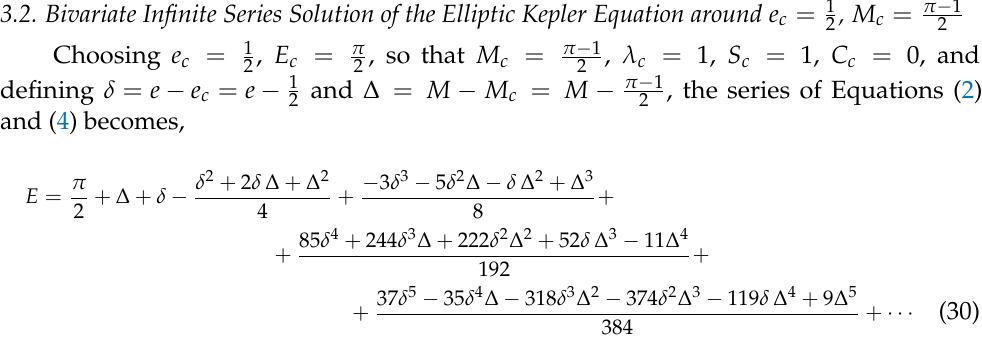
Figure 2. Contour levels of the error E 5 ( e , M ) affecting the fifth degree polynomial approximation, Equation (27), as a function of the eccentricity e and the mean anomaly M (both in logarithmic scales). The continuous magenta curve marks the boundary of the region of convergence, as estimated with Equations (20) and (26). The vertical dotted line represents the limit of the region of convergence for Lagrange’s univariate